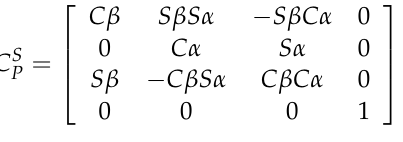
Figure A2. The structure of the LRORS. The S coordinate system has its origin at the principal point of the imaging system, and the Z S axis is the LOS of the imaging system. When the outer and inner gimbal angles are α and β , the matrix transformation from the P coordinate system to S coordinate system can be expressed as